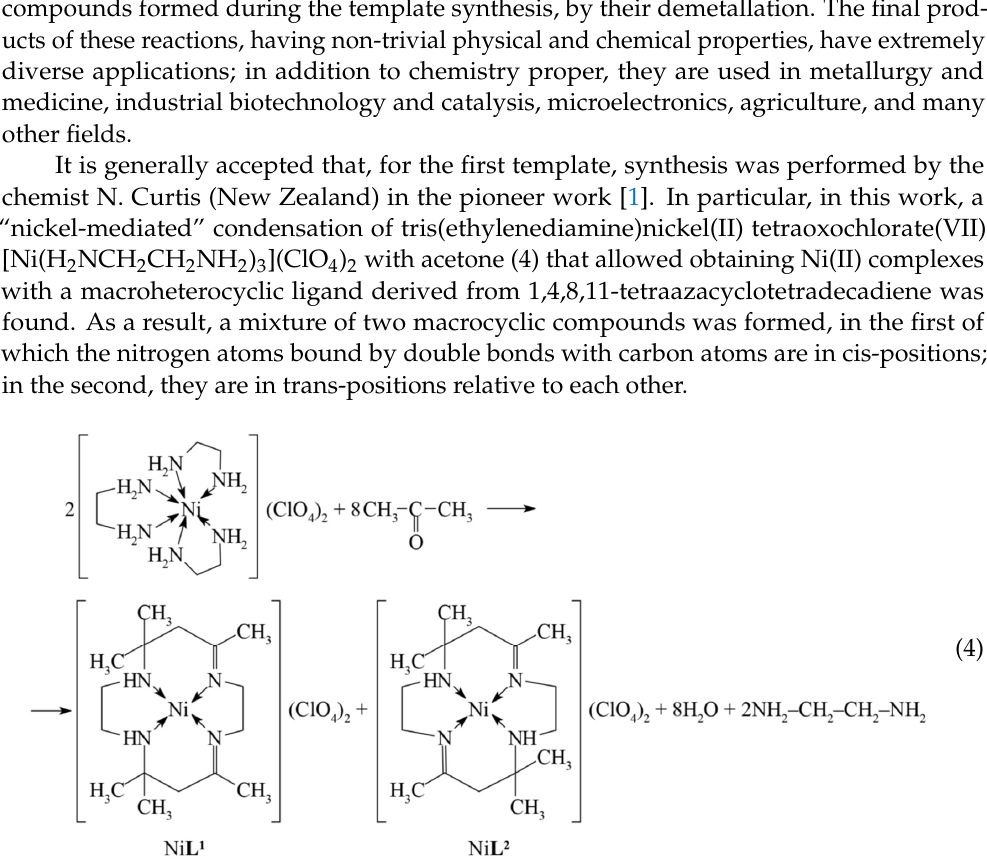
Figure 1. The structural formula of copper(II)